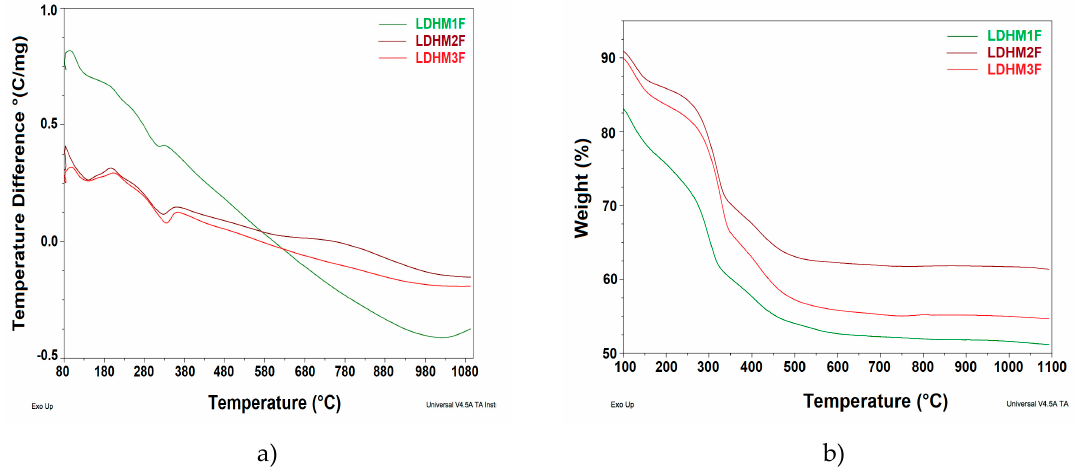
Figure 2. Thermal analysis of Mg / Fe layered double hydroxides. ( a ) Di ff erential thermal analysis (DTA) and ( b ) thermogravimetric analysis (TGA).